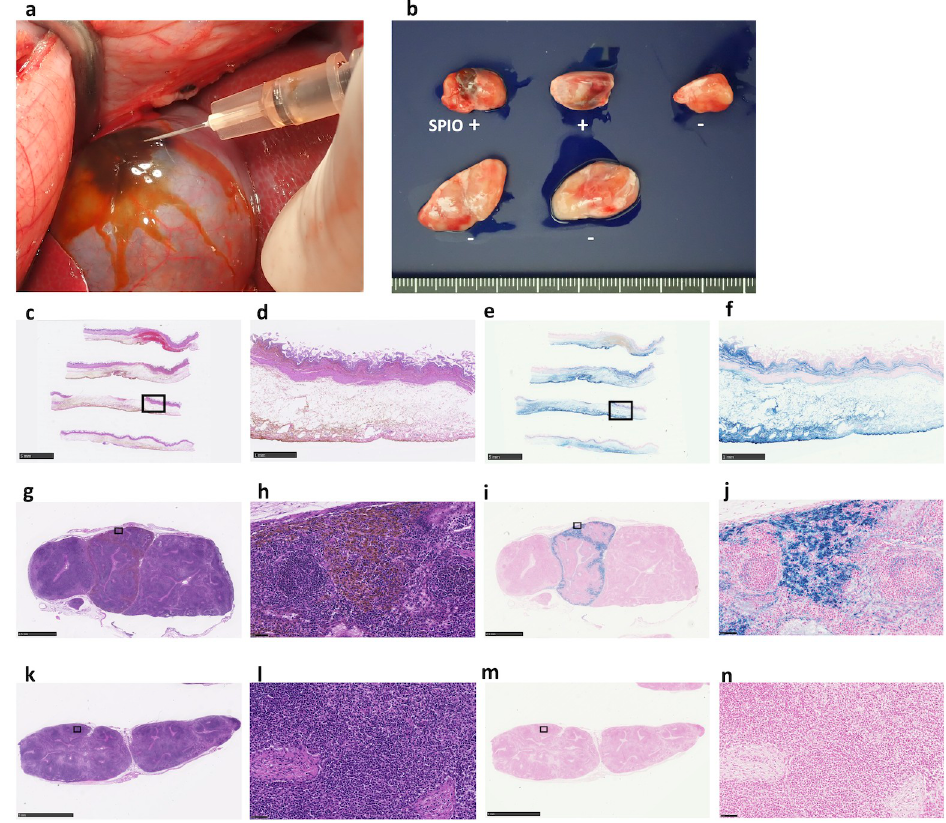
Fig 3. Histological examination of the gallbladder and lymph nodes from wild-type swine in open surgery. ( a ) Injection of the superparamagnetic iron oxide (SPIO) tracer into the gallbladder wall. ( b ) Five resected regional lymph nodes. ( c, d ) Haematoxylin and eosin staining and ( e, f) iron staining of the gallbladder. ( g, h ) Haematoxylin and eosin staining and ( i, j ) iron staining (Perl’s Prussian blue) of an SPIO-positive sentinel lymph node (SLN). ( k, l ) Haematoxylin and eosin staining and ( m, n ) iron staining of an SPIO-negative lymph node. Scale bar = 5 mm ( c, e, k, m ), 1 mm ( d, f ), 2.5 mm ( g, i ) and 50 μ m ( h, j, l, n ).